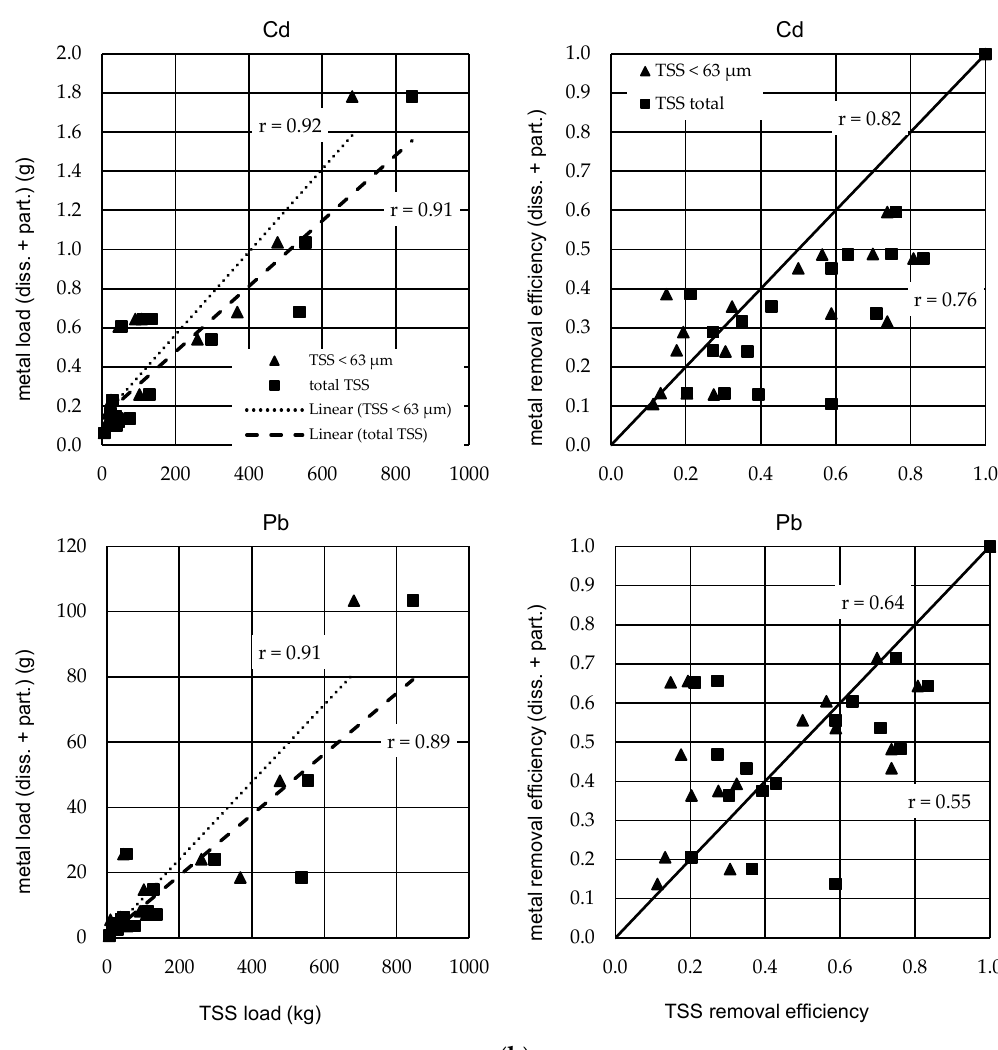
Figure 10. ( a ). Left: Correlation between total metal load (y-axis) and TSS load (x-axis) for <63 µm and total TSS (see key in first diagram). Right: Correlation between metal removal efficiency (y-axis) and TSS removal efficiency for <63 µm and total TSS. Line represents bisector, r values <63 µm top, r values total TSS bottom both for chromium (Cr), copper (Cu), zinc (Zn). ( b ). Same content as 10a.but for cadmium (Cd) and lead (Pb).